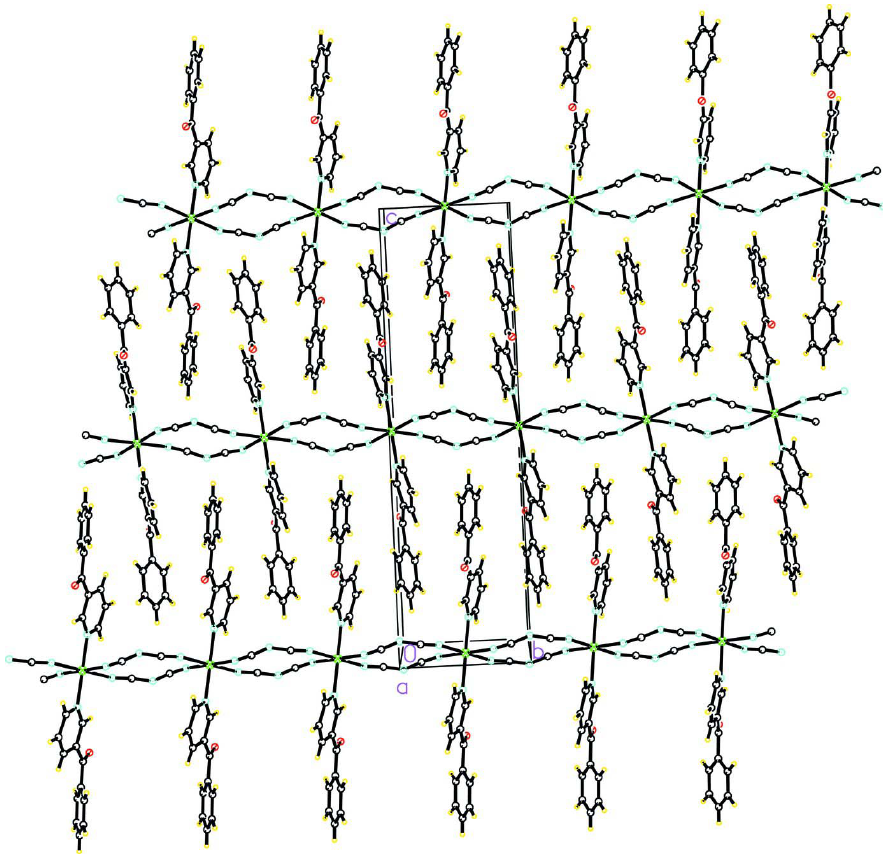
One-dimensional structure in the title compound. Displacement ellipsoids are drawn at the 30% probability level and all dydrogen